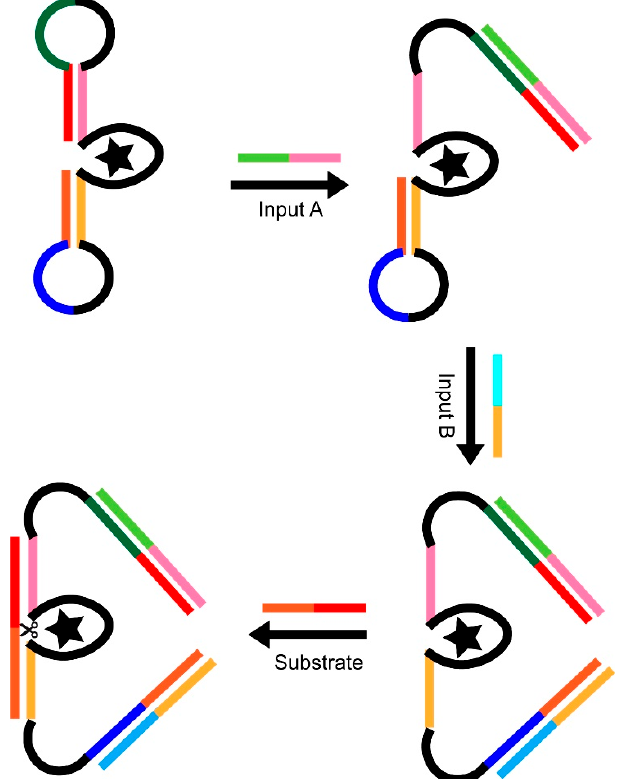
Figure 8. Schematic of a DNAzyme-based AND gate. Different DNA sequences are shown in different colors, with black representing regions that do not form base pairs. Shades of the same color represent complementary sequences. In the absence of input strands, the regulatory loops prevent the substrate strand from binding to the active site (represented by a star) and being cleaved. Binding of both input strands allows the substrate to bind at the active site, resulting in cleavage of the substrate strand.